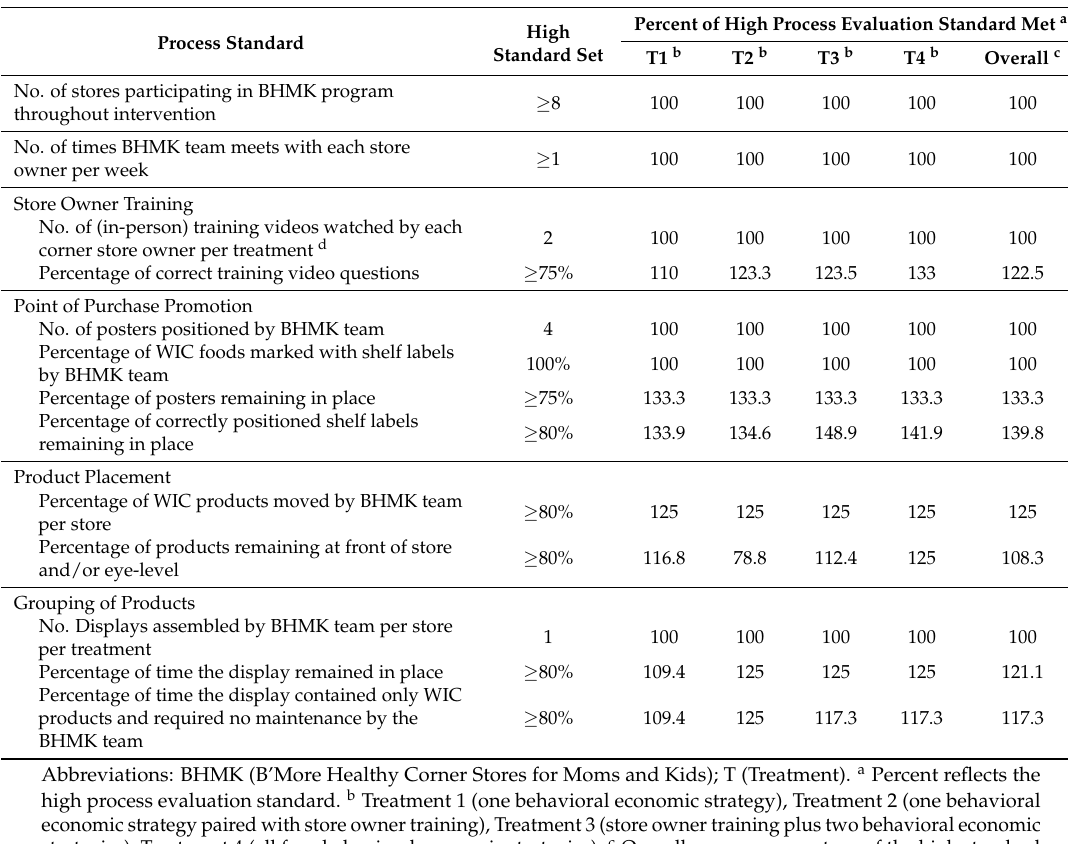
Table 2. Process evaluation of behavioral economic strategy implementation in the BHMK program: Percent of High Standard